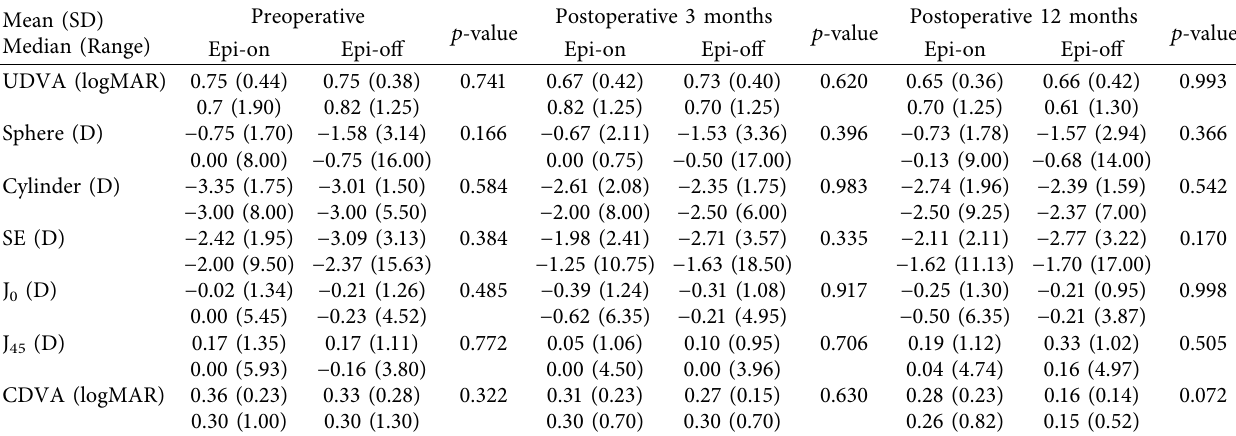
Table 2: Differences between the epi-on and epi-off groups in the visual and refractive parameters in the different visits of the follow-up. Mean (SD) Median (Range) UDVA (logMAR) 0.75